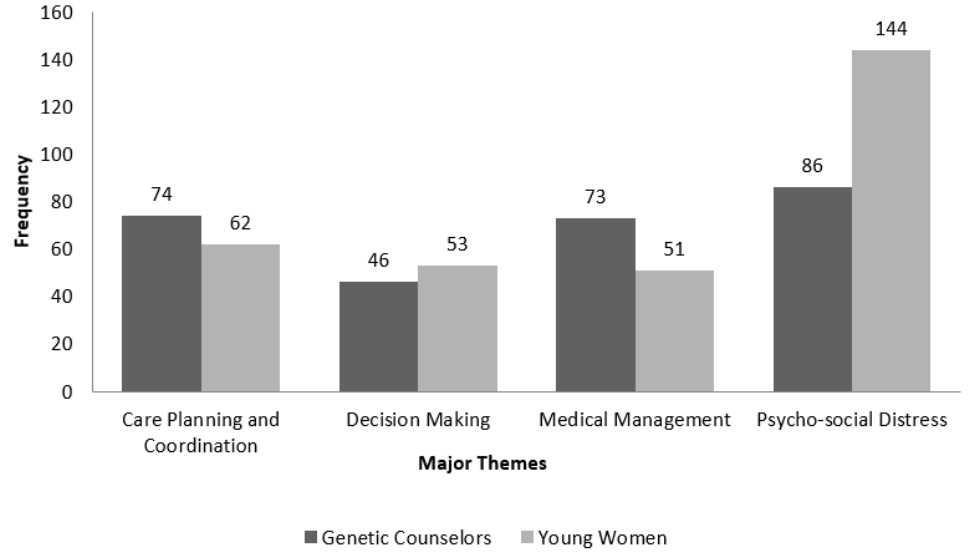
Figure 1. Frequency differences of major themes by group.